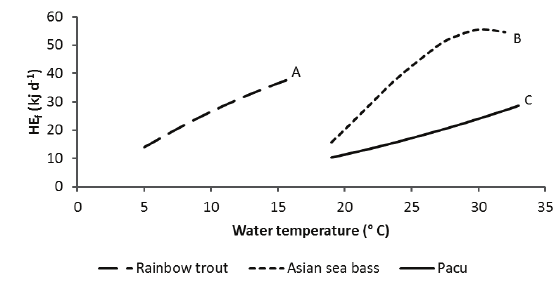
Figure 4 - Comparative, predicted fasting heat losses for 1-0 kg fish of three fish species: (A) rainbow trout, Oncorhynchus mykiss (Cho and Bureau 1998); (B), Asian sea bass, Lates calcarifer (Glencross 2008) and (C) pacu, Piaractus mesopotamicus